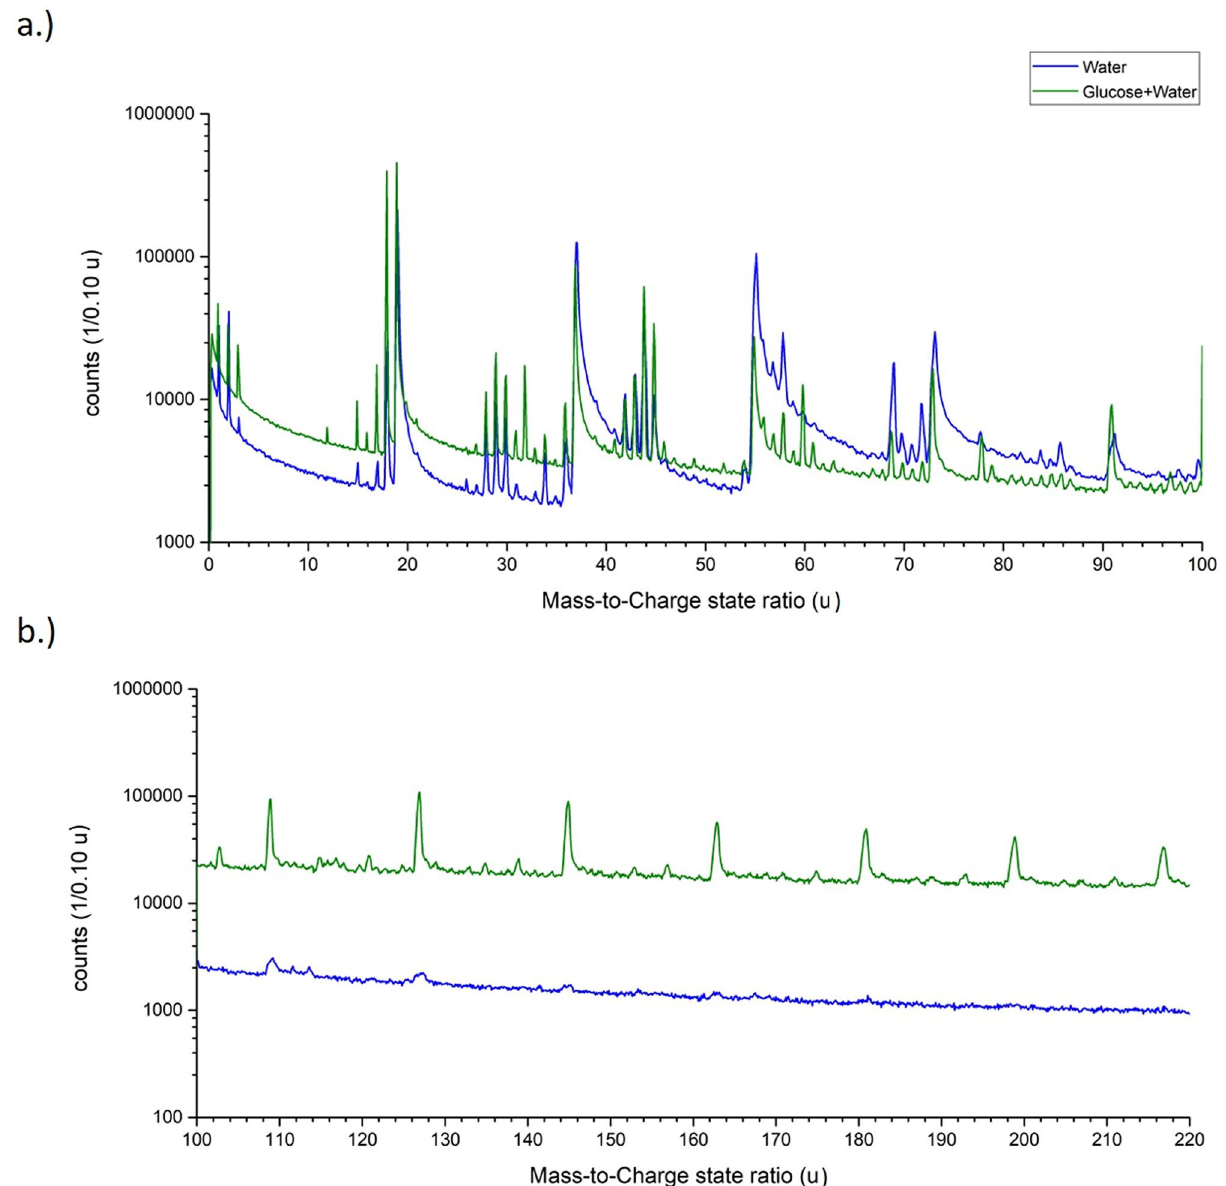
Figure 2. Comparison of the mass spectra of pure water and a saturated glucose solution. In ( a ) from the mass-to-charge state ratio of m/z = 0–100 u and in ( b ) from m/z = 100–220 u as logarithmic plot. In ( b ) the mass spectrum of the supersaturated glucose solution was shifted upwards by a factor of 10 to make both spectra more